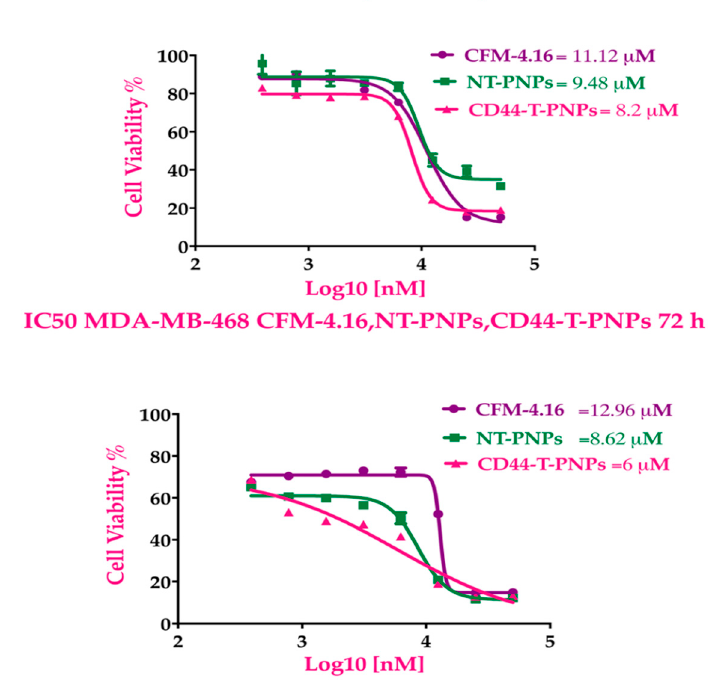
Figure 5. CFM-4.16 formulations cytotoxicity. The dose response curves of CFM-4.16, NT-PNPs and CD44-T-PNPs were plotted for MDA-MB-231 and MDA-MB-468 at 72 h Data represent mean ± SD, n = 8.